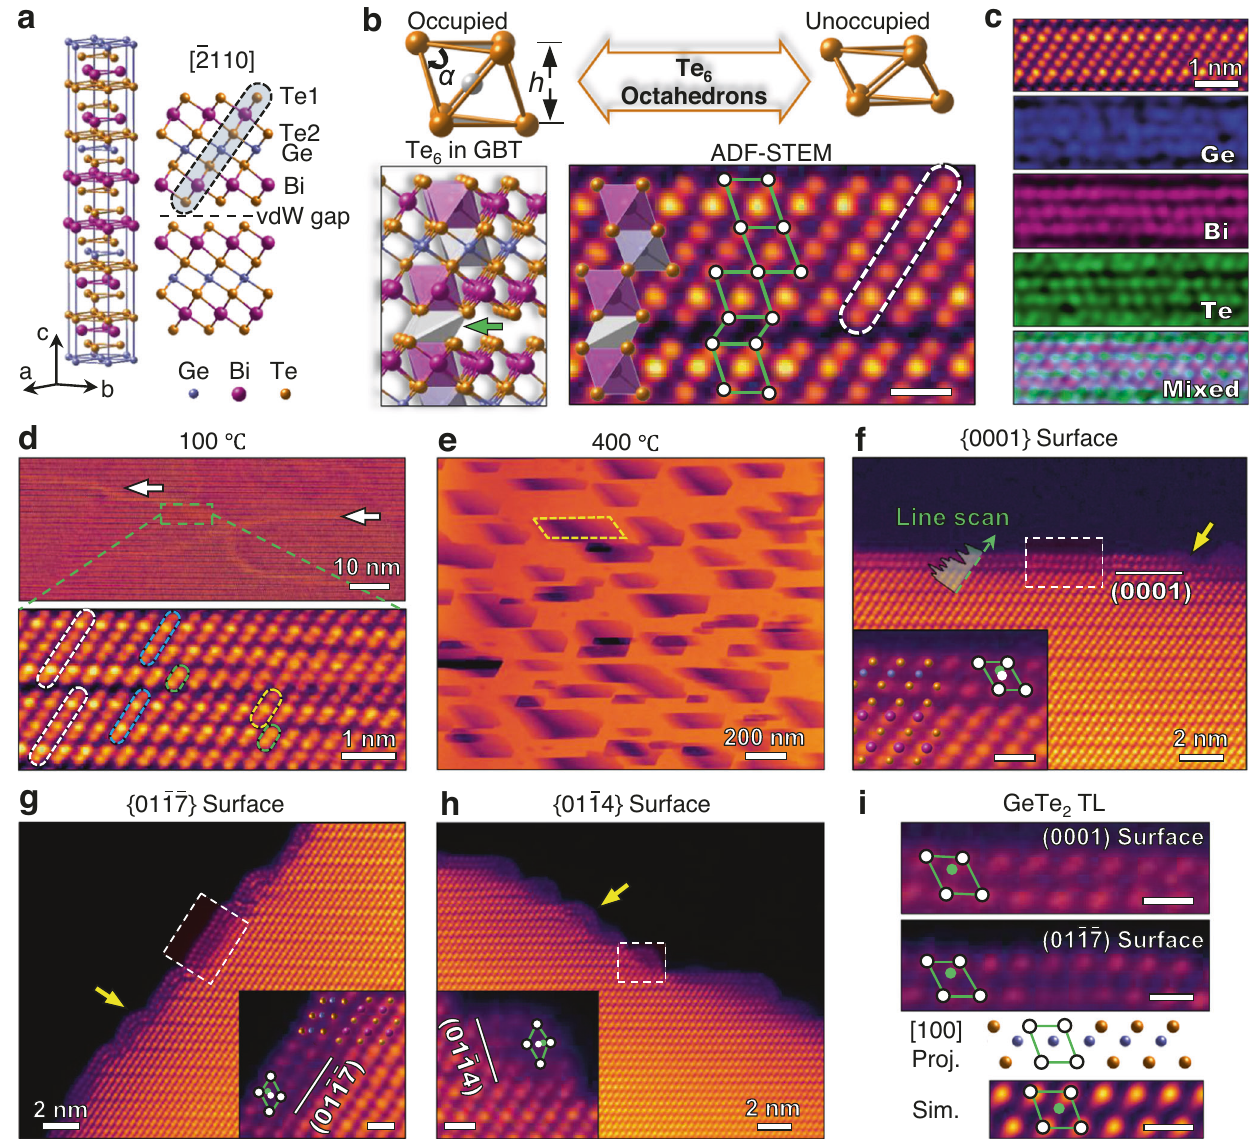
Fig. 1 | Structure characterization and reconstructed surfaces in GeBi 2 Te 4 (GBT) crystal. a Crystal structure model of the GBT septuple-layer (SL). b Atomic models of occupied (top left) and unoccupied (top right) Te 6 octahedrons with geometricparameters α and h .ThearrangementoftheTe 6 octahedronsintheGBT crystal structure, and the projected Te 4 parallelograms in the ADF-STEM image. c Atomic resolution EDS elemental maps of GBT, with Ge (purple), Bi (pink), Te (green) and the mixed. d ADF-STEM image of GBT acquired at 100°C. Septuple layers (SLs), quintuple layers (QLs), triple layers (TLs), double layers (DLs) are